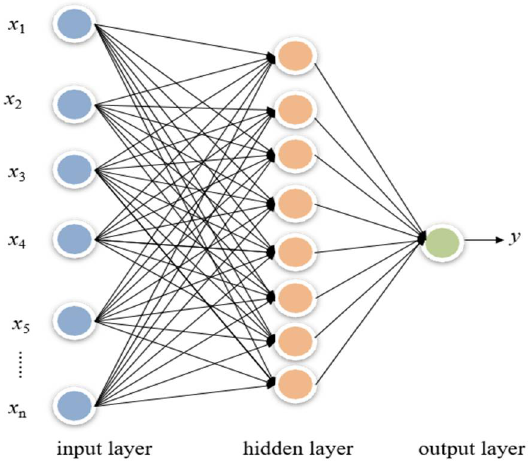
Figure 2. The schematic diagram of neural network structure.